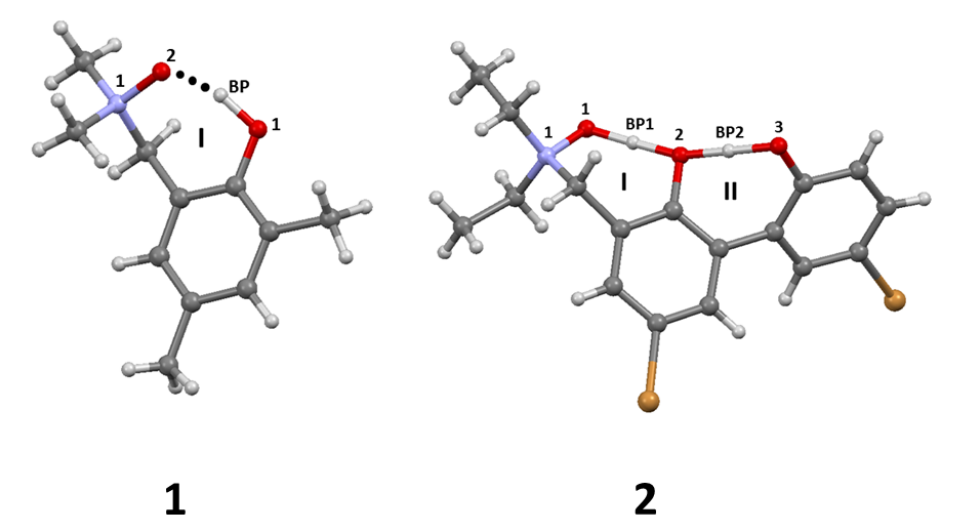
Figure 1. Molecular forms of studied N -oxides: 2-(N,N-dimethylamino-N-oxymethyl)-4,6- dimethylphenol ( 1 ) and 5,5’-dibromo-3-diethylaminomethyl-2,2’-biphenol N -oxide ( 2 ). The in- tramolecular hydrogen bridges are denoted O1-HBP. . .O2 in the case of 1 and O1-HBP1-O2 and O3-HBP2-O2 in the case of 2 . Atoms coloring and numbering scheme: nitrogen atom—blue, oxygen atoms—red, hydrogen atoms—white, carbon atoms—grey and bromine atoms—brown. BP—bridged proton. The presence of quasi-rings is denoted using I and II Roman